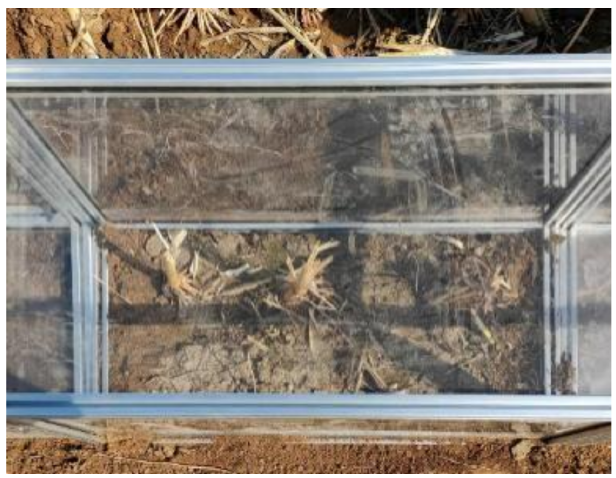
Figure 7. Surface of test